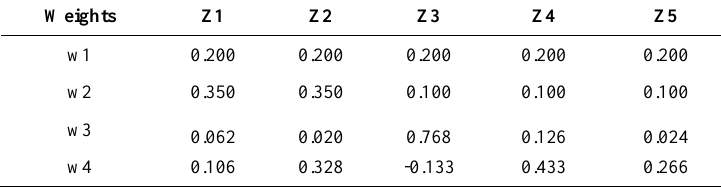
Table 7. Values of weighting indicators (Option